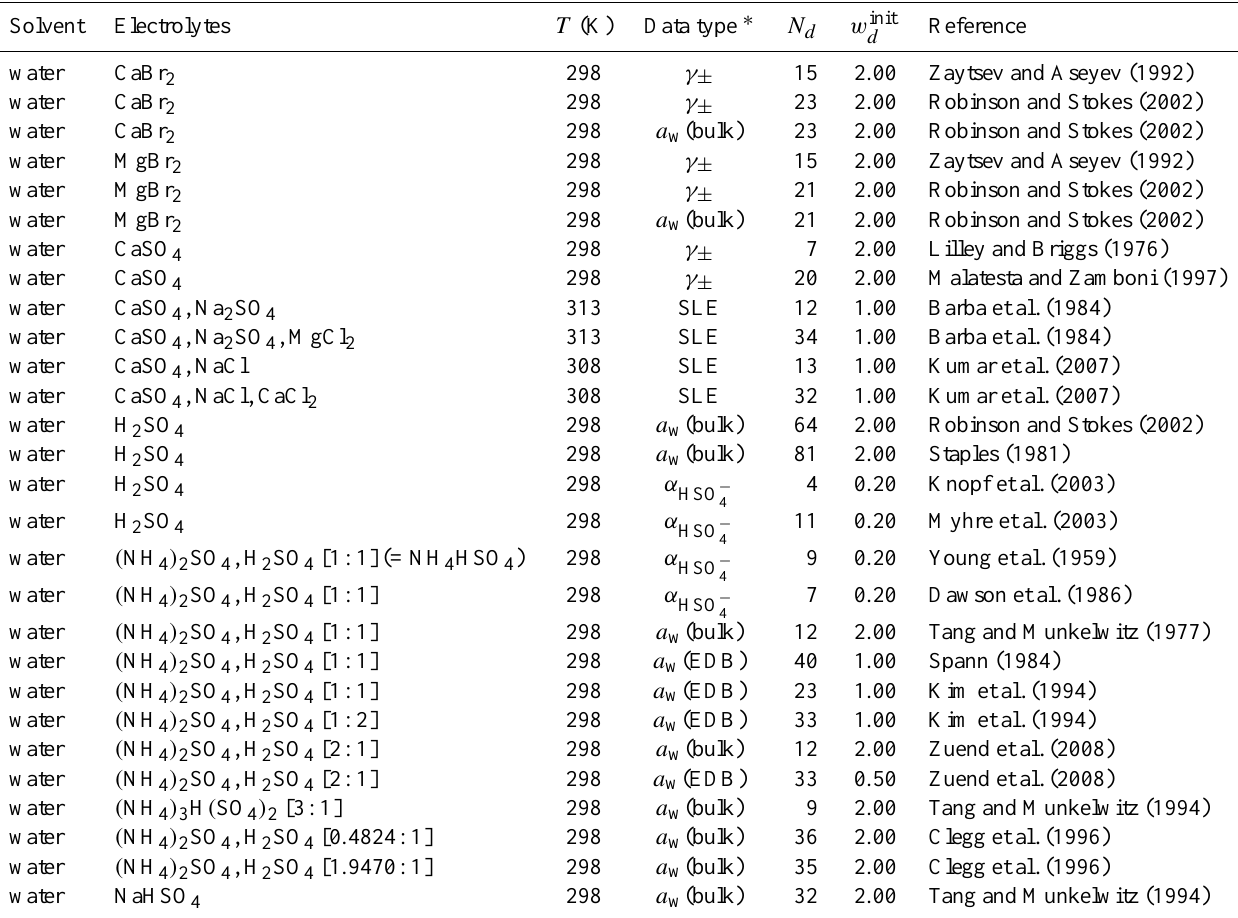
Table 4. Data types, number of data points ( N d ), initial weighting ( w init CaSO 4 , and H 2 SO 4 systems, aqueous multi-salt mixtures at SLE of CaSO 4 · 2H 2 O (gypsum), and mixtures of H 2 SO 4 and ( NH 4 ) 2 SO 4 at various molar mixing ratios as specified in brackets.